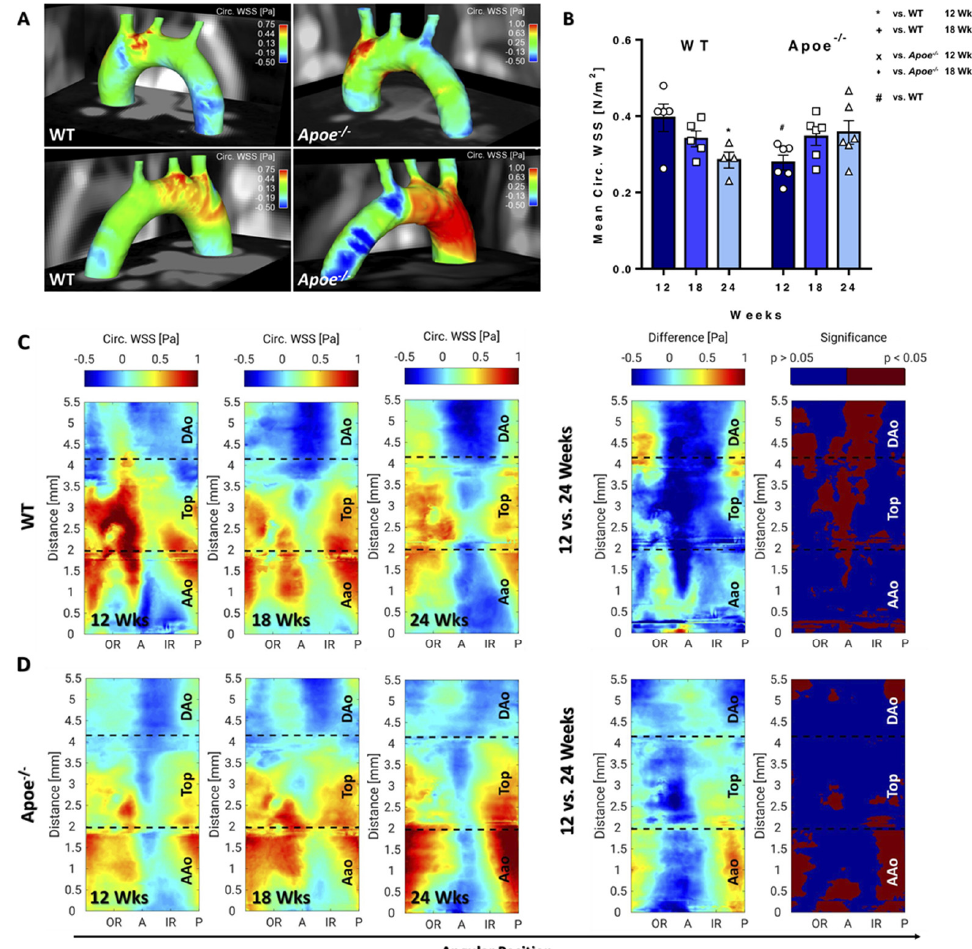
Figure 5. CircWSS shows inverse changes in Apoe − / − and WT mice. ( A ) Three-dimensional circWSS map of a 24-week-old WT mouse (left) and an Apoe − / − mouse (right) from anterior and posterior view. In comparison with the WT, high circWSS is visible in the posterior side of the AAo in the Apoe − / − mouse (red area in bottom right image). ( B ) Mean circWSS. WT mice showed significantly higher values at 12 compared to 24 weeks and compared with age-matched Apoe − / − mice. * vs. WT 12 weeks, p < 0.05; # vs. WT, p < 0.05. ( C ) CircWSS maps of WT mice (group average) for all measurement time points and statistical intragroup comparison of circWSS values (12 vs. 24 weeks), showing the difference maps of circWSS values and significance maps. ( D ) CircWSS maps of Apoe − / − mice.